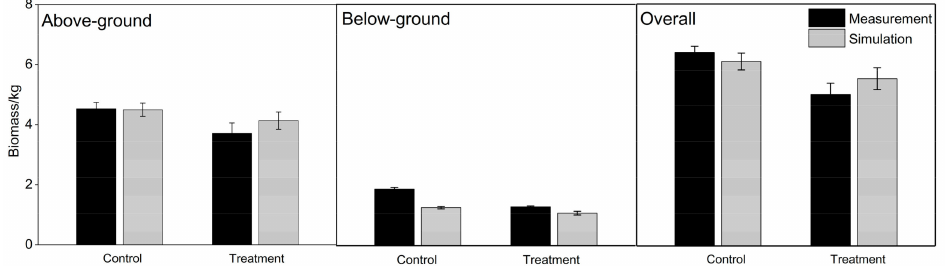
Figure 7. Comparison of measurements and simulations for the above-ground, below-ground and overall biomasses of trees from the control and dry-treatment